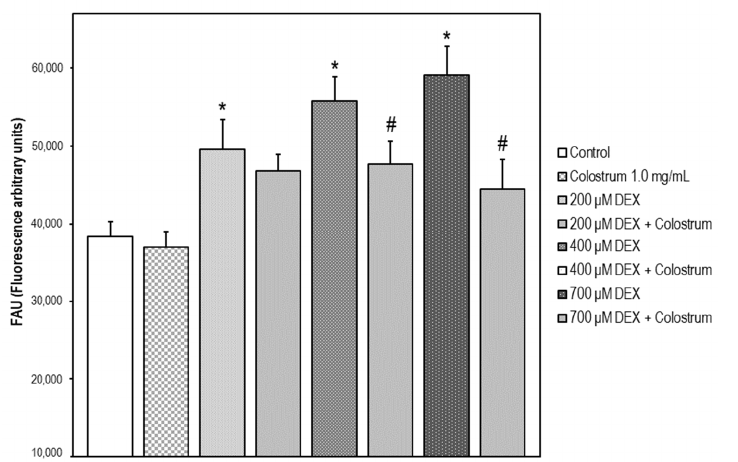
Figure 3. ROS production (DCFH-DA test) in SH-SY5Y cells after 48 h treatment with DEX. Data are given as the mean of fluorescence units ± S.E.M. of three separate experiments. The data are expressed as the mean ± S.E.M. of three independent experiments. Fluorescence was measured at λ exc = 485 nm (bandwidth 5 nm) and λ em = 520 nm (bandwidth 5 nm). A set of SH-SY5Y cells were treated with DEX in a concentration range of 0–700 µ M for 48 h. Significant differences were found in fluorescence intensity values elicited by every DEX concentration compared to the control untreated cells (Newman–Keuls test, * p < 0.05 vs. control). Another set of cells were treated with colostrum (1.0 mg/mL) for 1 h and then cell incubation continued with DEX (200, 400, or 700 µ M) for 48 h. Significant differences of DEX plus colostrum versus DEX-treated cells were found at 400 and 700 µ M DEX concentrations (Newman–Keuls test, # p <